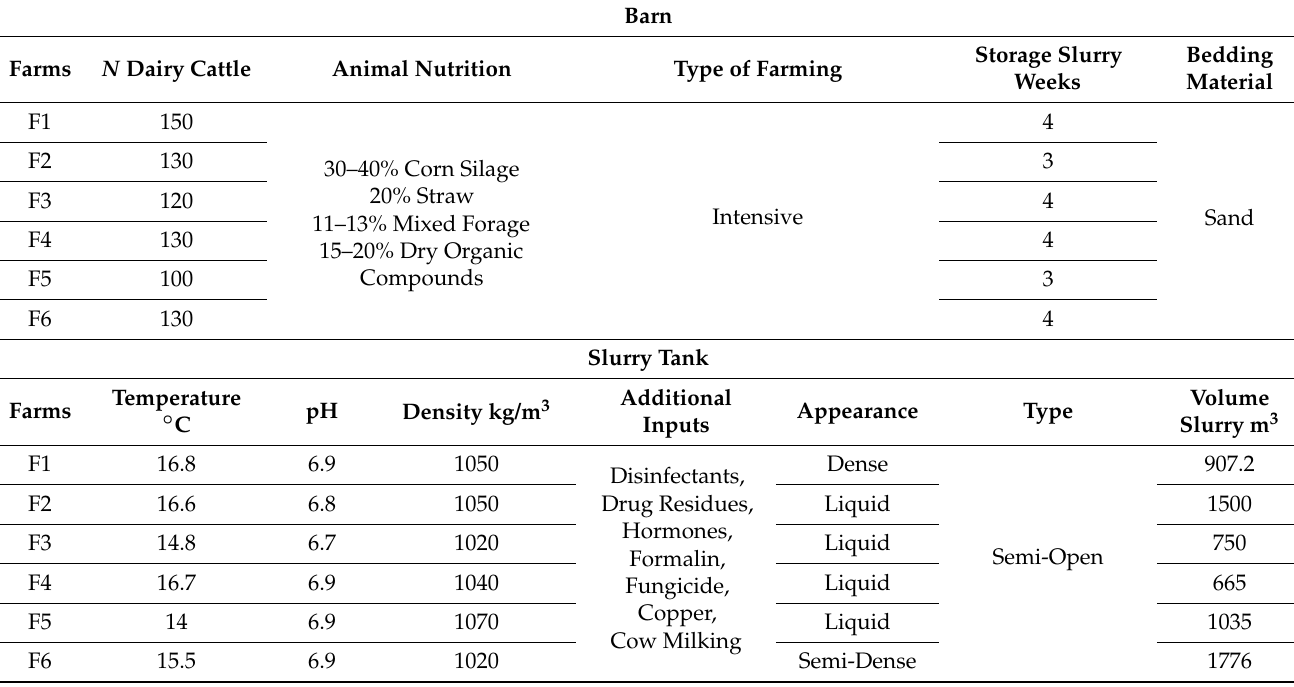
Table 1. Status of the farms and properties of the slurries.